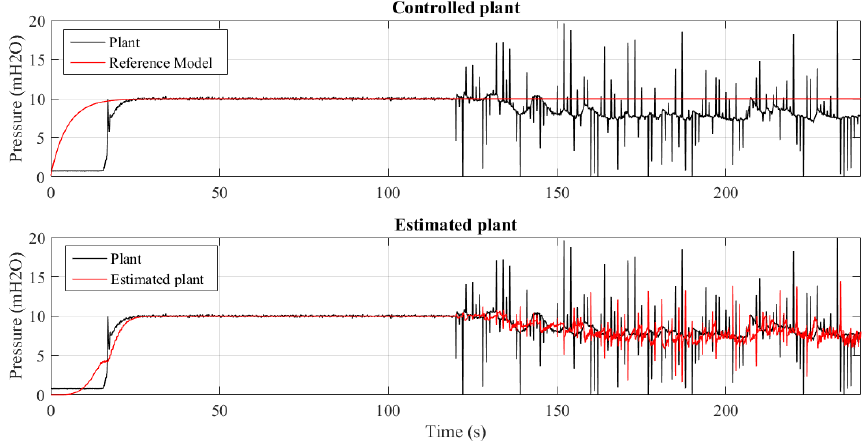
Figure 17. System using the MSE criterion subjected to outliers at intervals of every 1 s.